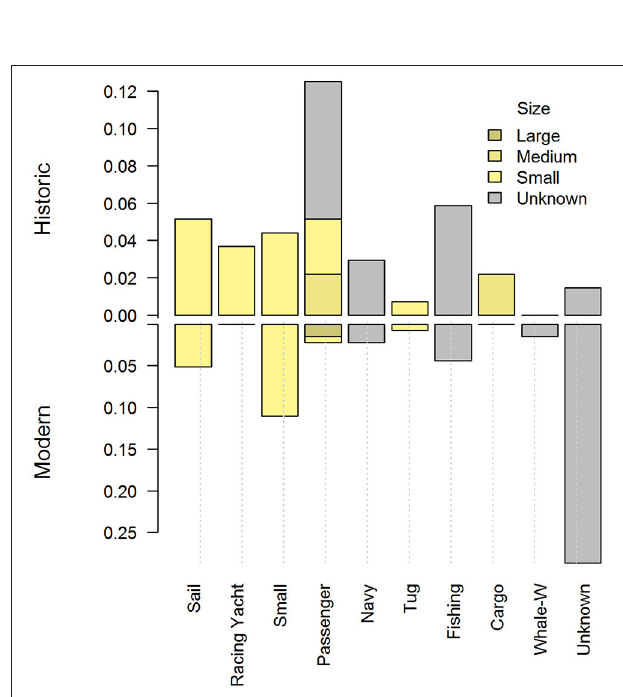
FIGURE 8 | Within season timing of Australian vessel strike reports: (A) all whales; (B) humpback whales; (C) Southern right whales; and (D) sperm whales. (image credit: http://phylopic.org/).